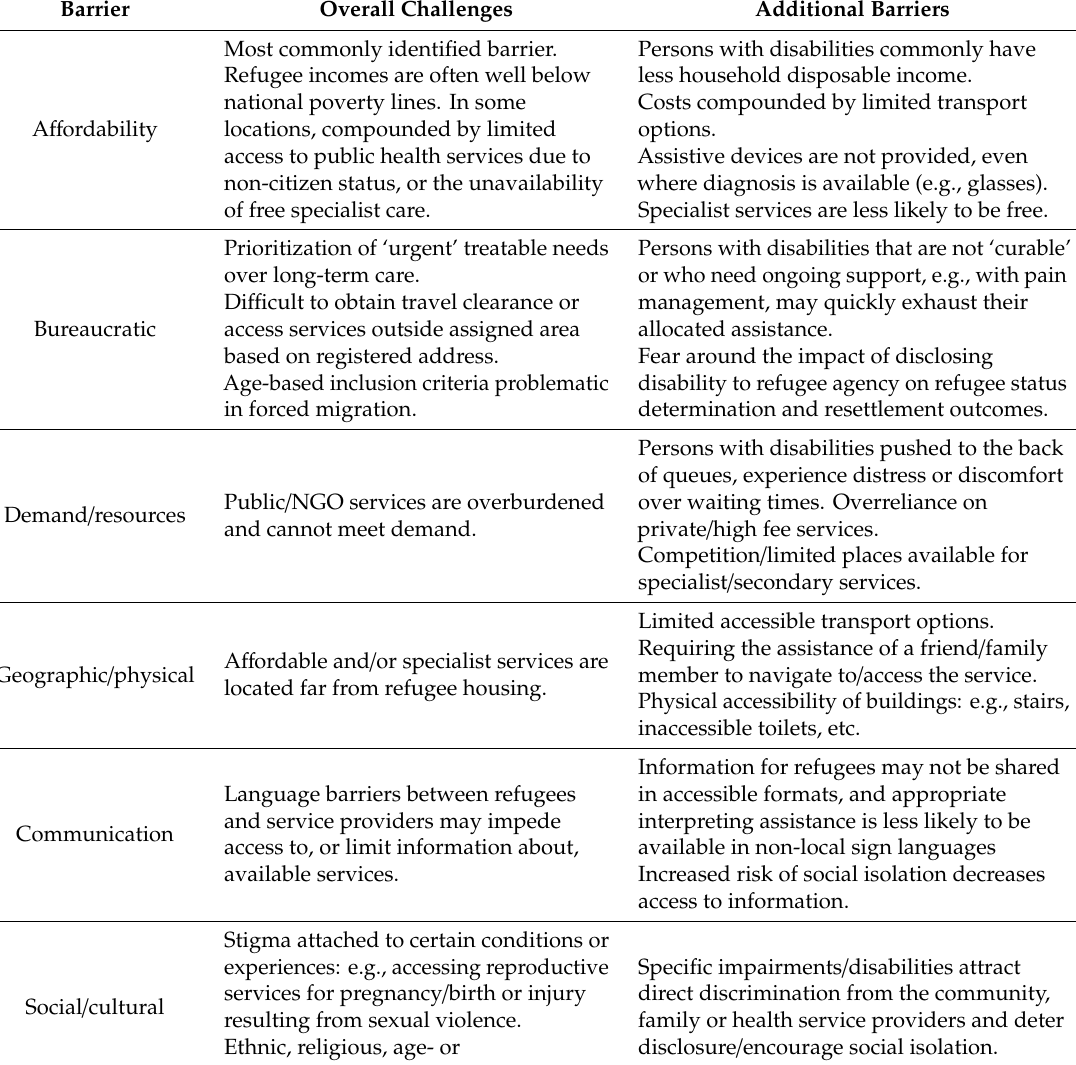
Table 3. Common barriers to accessing health services for refugees and additional barriers for persons with